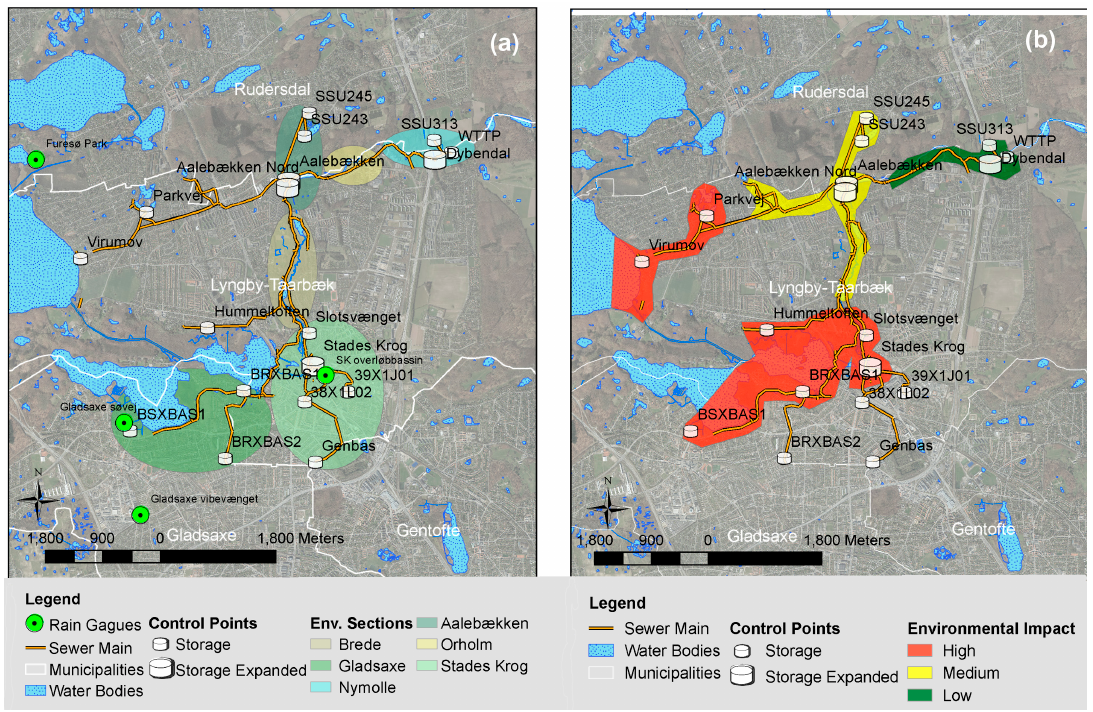
Figure 1. Overview of the Mølle Å river system, the urban drainage system (UDS), and storage volumes in the Lundtofte catchment: ( a ) location of the rain gauges and regulated environmental sections; and ( b ) potential impact of overflows river sections, also referred as environmental impact areas (see Appendix A2 for more details).